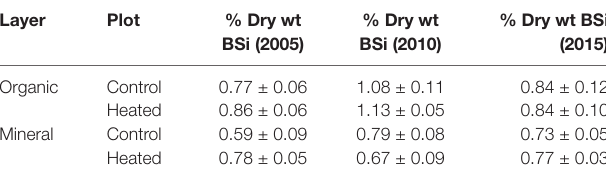
TABLE 1 | Soil BSi concentrations by